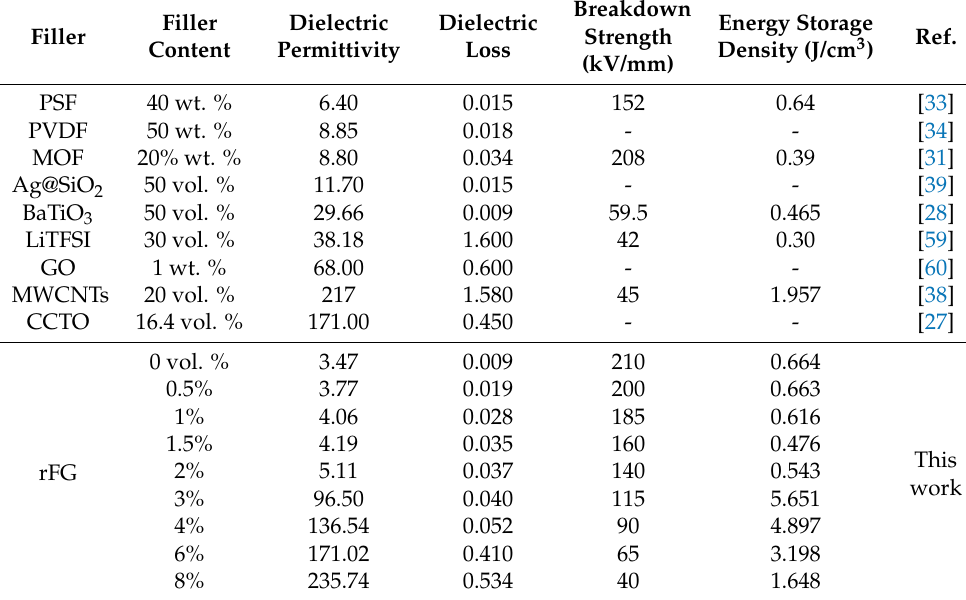
Table 2. The dielectric properties of various PI composite